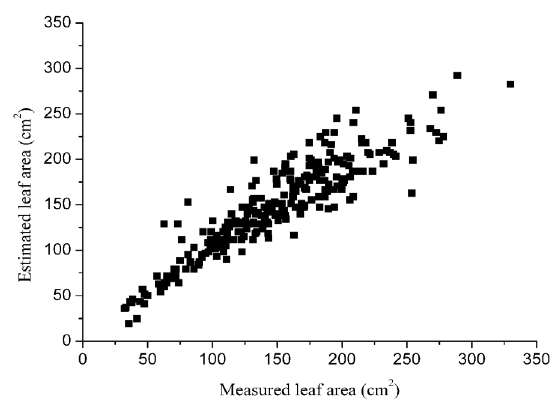
Figure 3 - Dispersion of data between the measured leaf area (cm 2 ) and the estimated leaf area (cm 2 ) using the function LA = -69.91114 + 15.06462L in cassava leaves, cultivar IAC 576- 70, at 80 days after planting in the region of Botucatu, SP, Brazil. (LA = leaf area; L = lobe length).